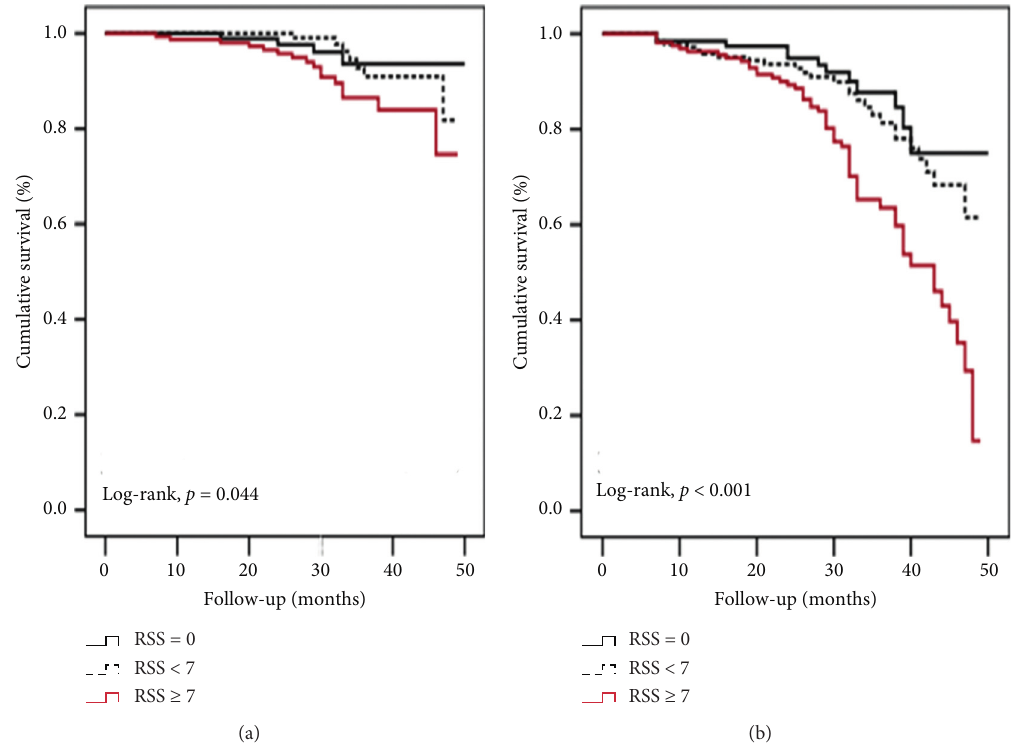
Figure 3: Kaplan–Meier survival curve for cardiovascular death (a) and MACE (b) (MACE: major adverse cardiac Cutoff values for cardiac death were found as 13, 22, and 126, SS. Cutoff values for MACE were 6, 19, and 121, respectively. respectively. AUC of RSS was higher than AUC of the SS and AUC of RSS was higher than AUC of SS and GS. GS. Cutoff values for MACE were found as 11.5, 17, and 119, ROC analysis was performed for cutoff values of RSS, SS, respectively. AUC of RSS was higher than the SS and GS. and GS which predict long-term cardiac death and MACE.